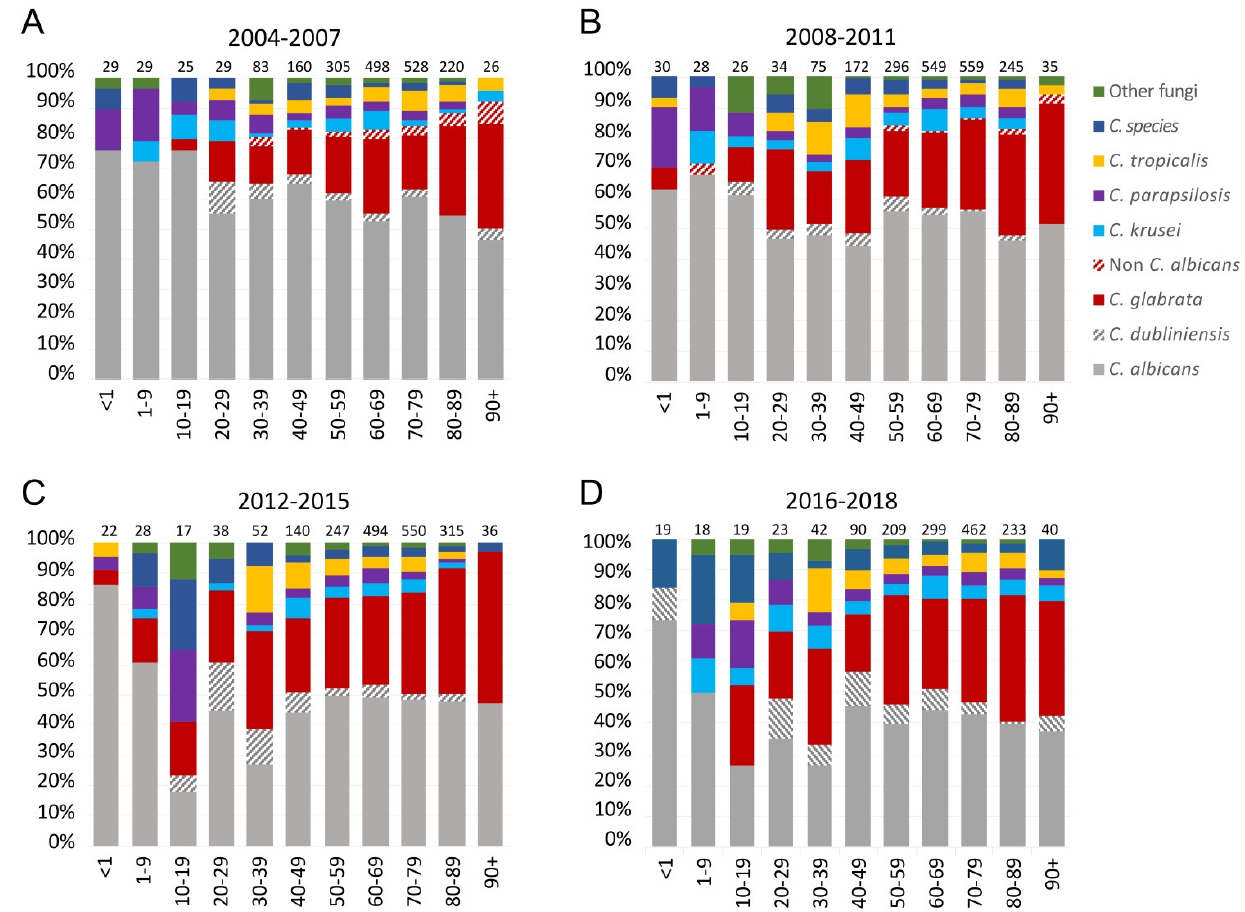
Figure 4. Species distribution in proportions (%) among age groups (years) in the four periods 2004 to 2007 ( A ), 2008 to 2011 ( B ), 2012 to 2015 ( C ), and 2016 to 2018 ( D ). Number of total number of isolates within one age group is stated. Data from 2004 to 2015 have previously been published by Astvad et al. [10].